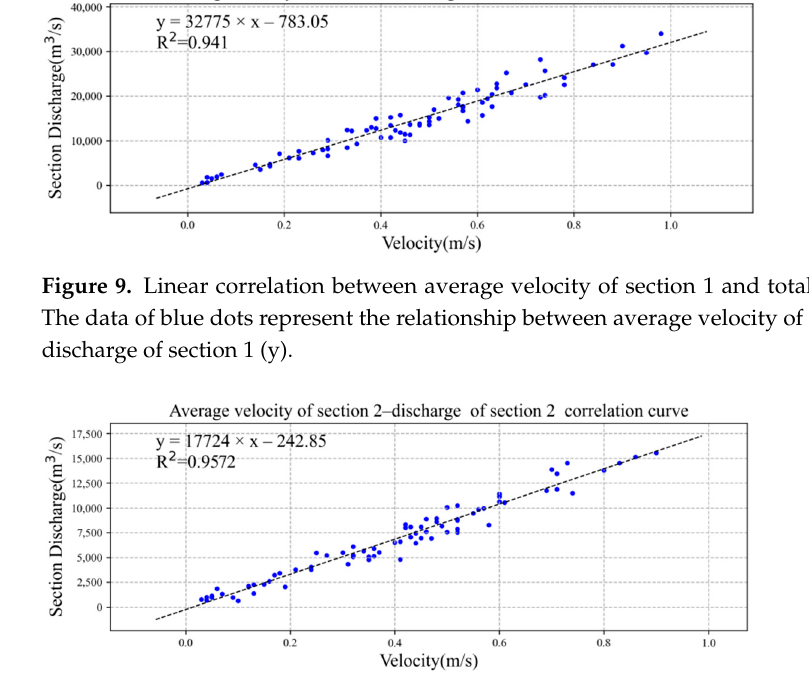
Figure 12. Linear correlation between vertical average current of fixed ‐ site buoy and average velocity of section 2. The data of blue dots represent the relationship between vertical average velocity of the fixed ‐ site buoy(x) and average velocity of section 2(y). 4.3. Correlation Formula between Fixed ‐ Site Vertical Average Velocity and Section Discharge Method 1: Using the formula “total discharge of section = average velocity of section × section area”, we replaced relevant formulae (9) and (10) to calculate the average velocity of both sections and the measured tide level with relevant formulae (5) and (6) to obtain the tide level and section area of section 1 and section 2, as follows: Q 1 = (1.2039Vb + 0.0435) × (27.391TL + 23228),